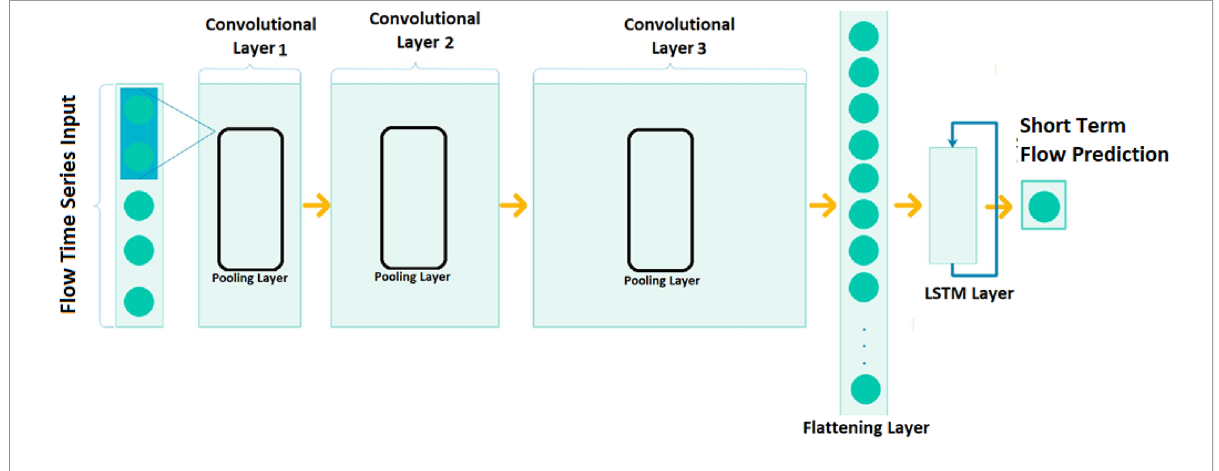
Figure 4. Topological structure of Convolutional neural Network (CNN) integrated with Long Short-Term Memory (LSTM) Network used in this study for the prediction of short-term (hourly) streamflow ( Q , m 3 s −1 ) at Brisbane River and Teewah